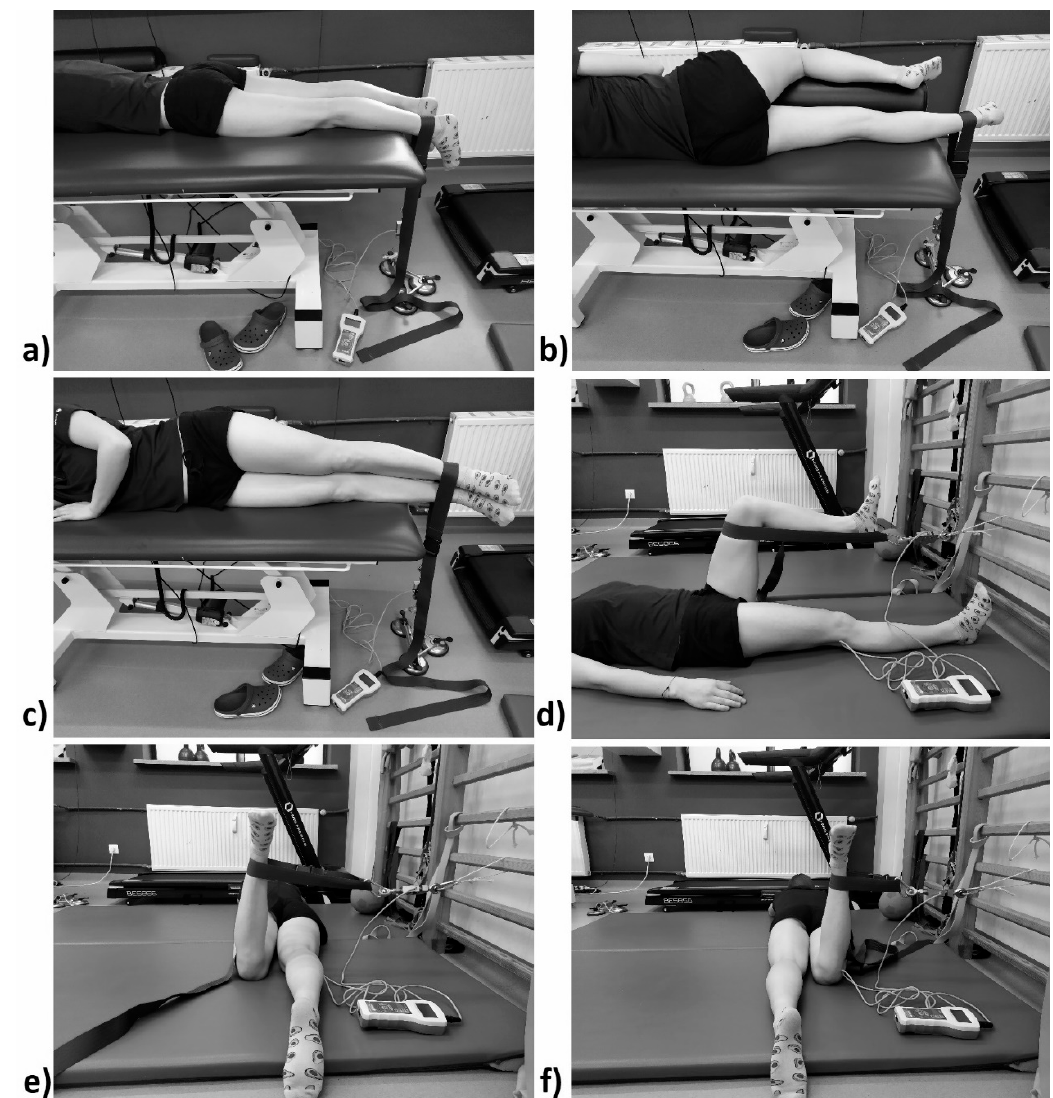
Figure 3. Positions for strength measurements: ( a ) flexion; ( b ) extension; ( c ) abduction; ( d ) adduction; ( e ) internal rotation; ( f ) external rotation. Authors’ own materials .